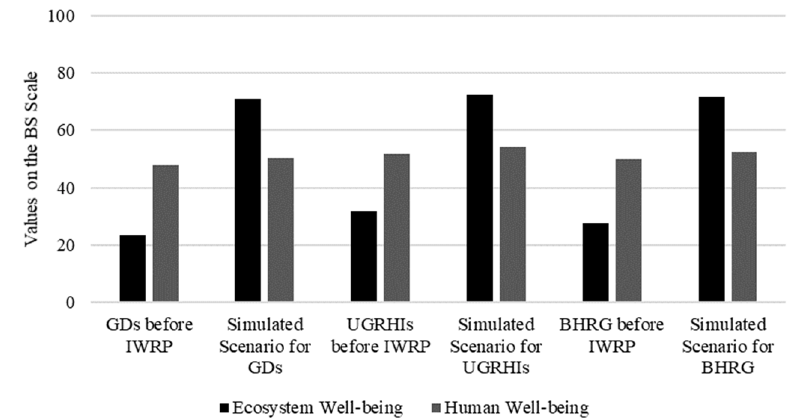
Figure 9. GDs (Minas Gerais Water Management Units), UGRHIs (São Paulo Water Management Units), and IWRP (Integrated Water Resources Plan). Scenario created for the BHRG with the economic dimension unchanged. Changes in the social dimension (housing thematic area) and the environmental dimension (all thematic areas) were considered. This scenario consists of implementing all water management instruments and achieving an “acceptable” condition for environmental sanitation, water monitoring, native vegetation, and housing. The mean values for all water management units (on the BS scale) were